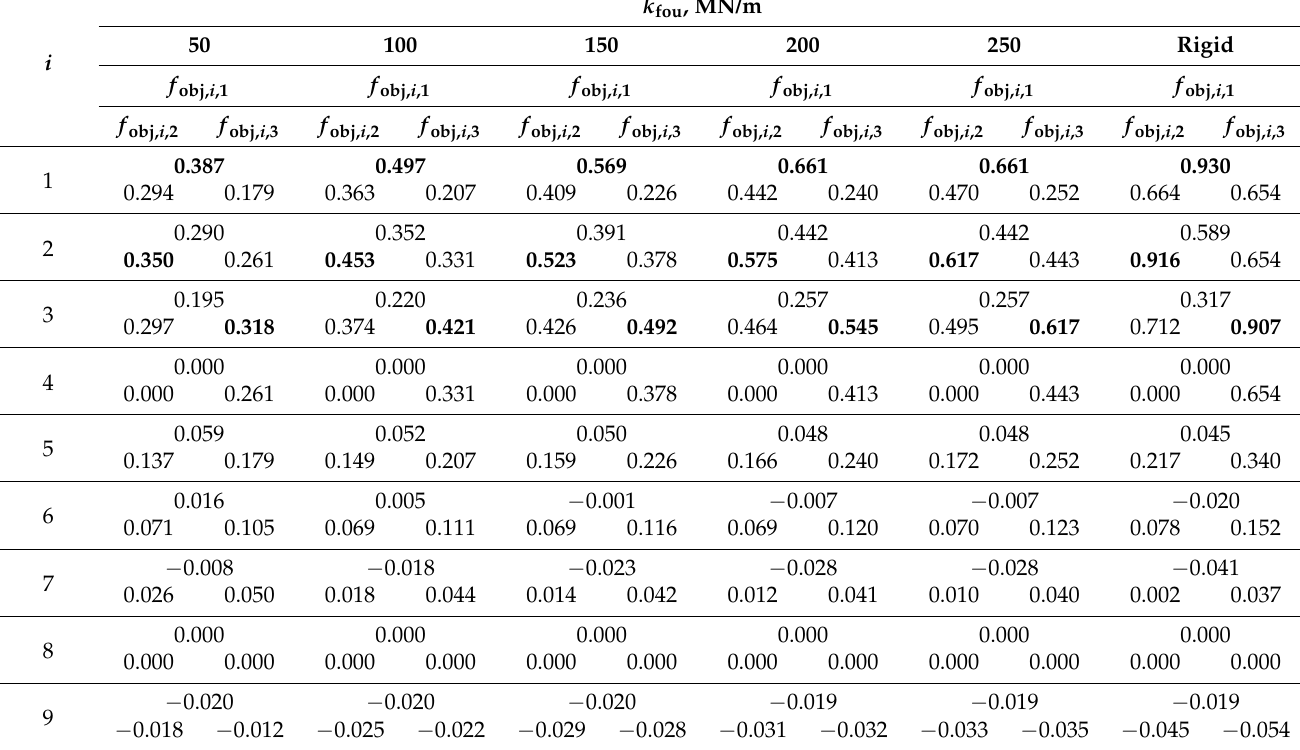
Table A10. Values f obj, i , j , [-] of the matrix f obj of object displacement forms for n = 32, k fou = 50, 100, 150, 200, 250 MN/m and k fou - rigid (elements f obj, i , i ( i = j ) are given in